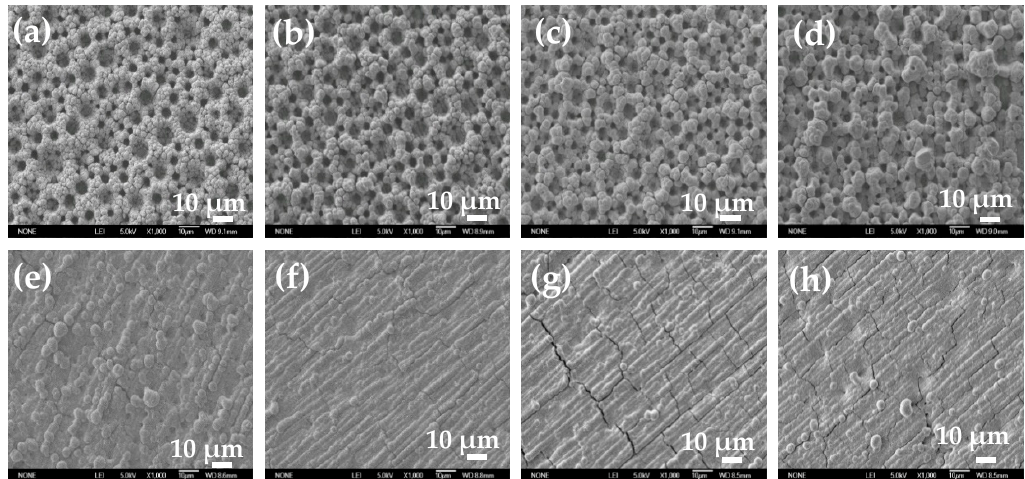
Figure 5. SEM images of Ni films electrodeposited in 0.2 M NiCl 2 , 2 M NH 4 Cl, and 1 M NaCl solutions with different pH values of 3 ( a ), 6.5 ( b ), 7.1 ( c ), 7.7 ( d ), 8.1 ( e ), 8.3 ( f ), and 9.1 ( g ), and with 0.1 M EDTA ( h ). Magnification: 1000 × .